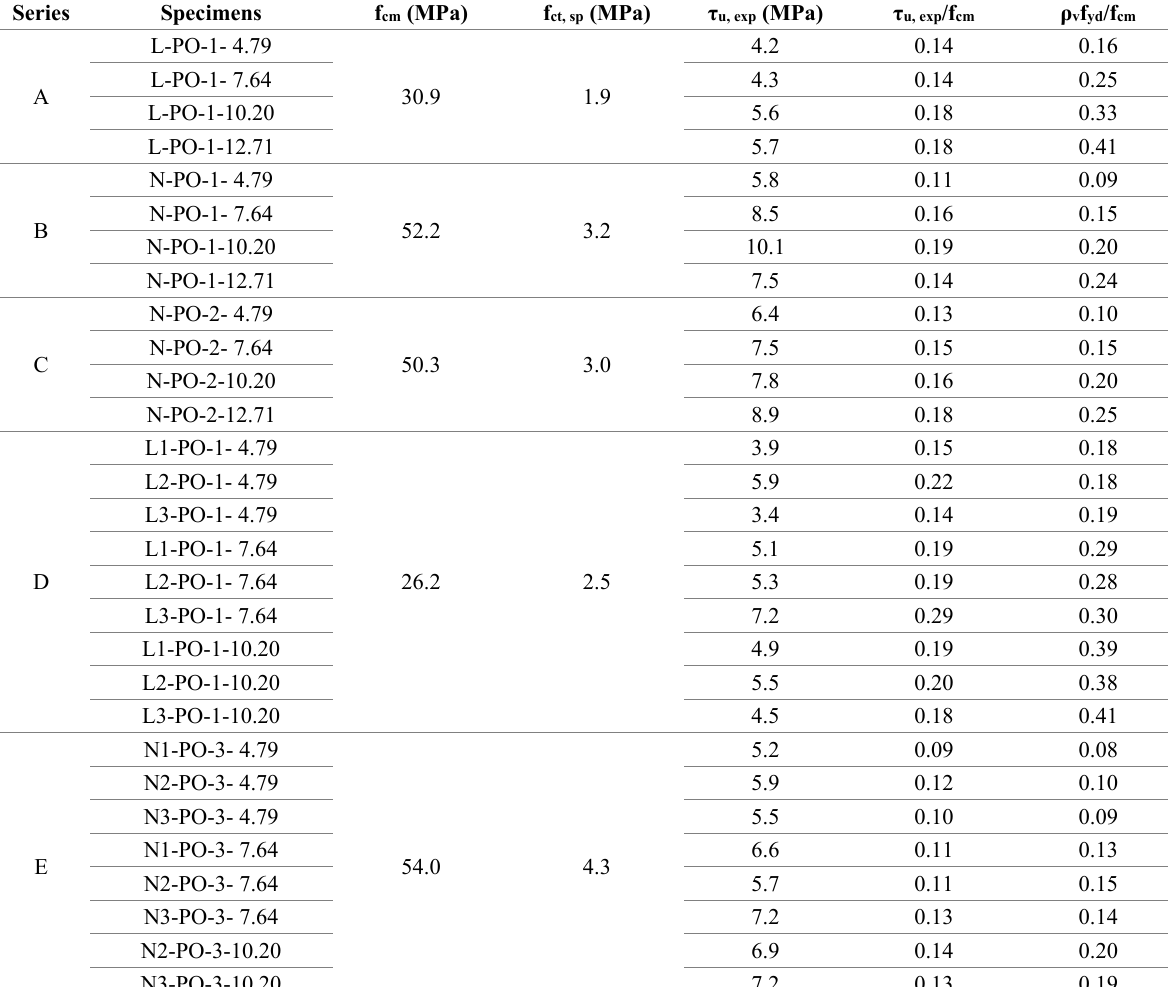
Table 2. Results of compression, splitting tensile and direct shear tests.